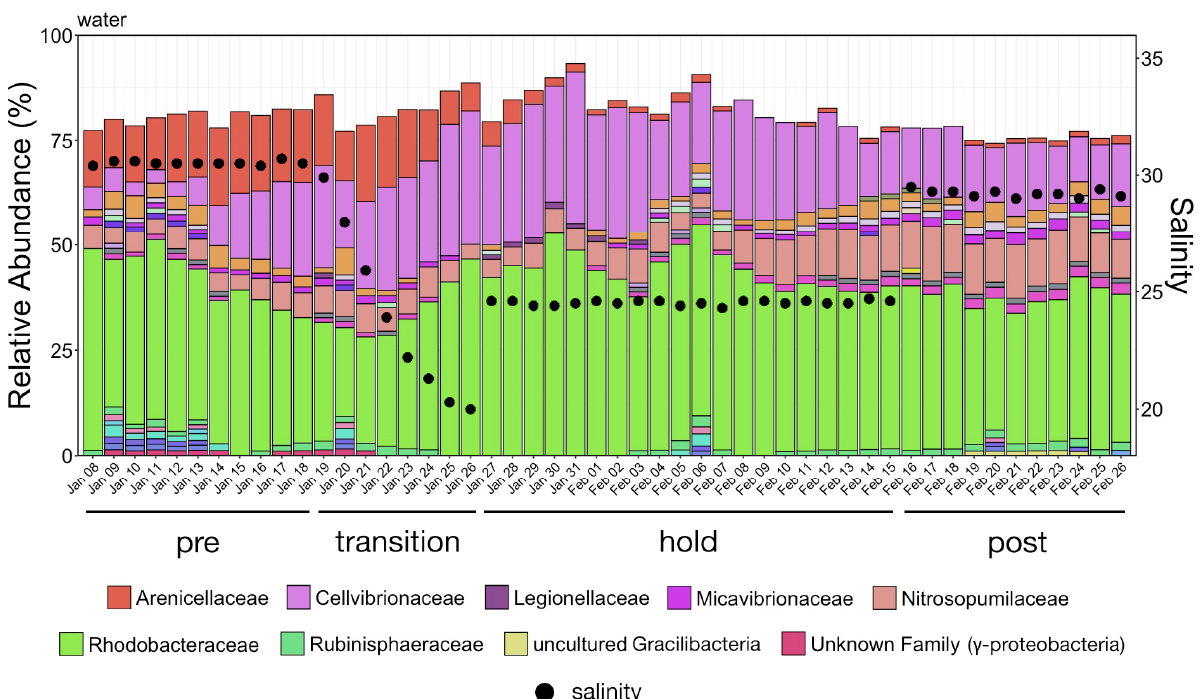
Figure 5. Barplot demonstrating the mean relative abundances of families making up greater than 1% of the overall community for water samples throughout the water change. Salinities for each day are overlayed with black points. The 9 most abundant families across are samples are displayed in the legend.